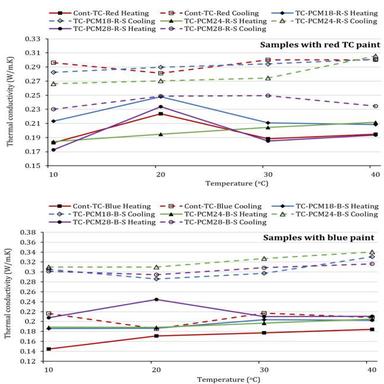
Thermal conductivity of Type 2 samples in the heating and cooling cycle.